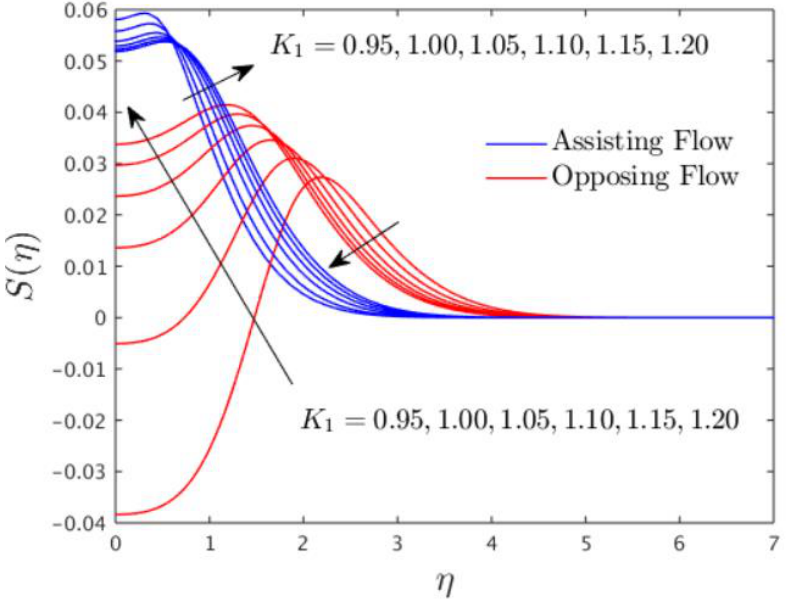
K . Figure 7. S ( η ) against K 1 . 1